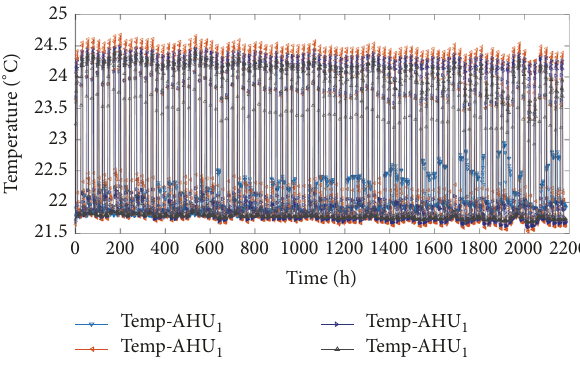
Figure 11: Actual data of return air temperature of the building for each AHU.